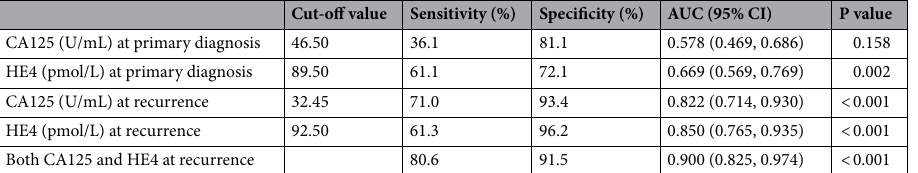
Table 3. Prediction performance of type II EC recurrence assessment by serum CA125 and HE4. CI confidence